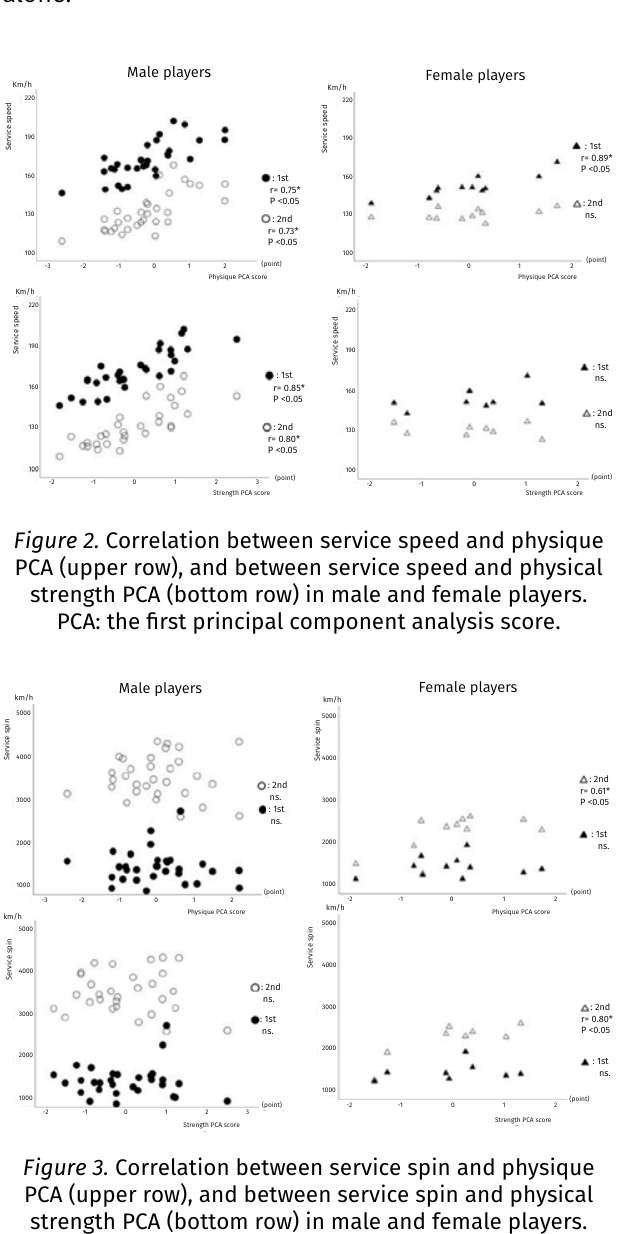
Figure 4. Correlation between service speed and impact height (upper row), and between service speed and impact depth (bottom row) in male and female